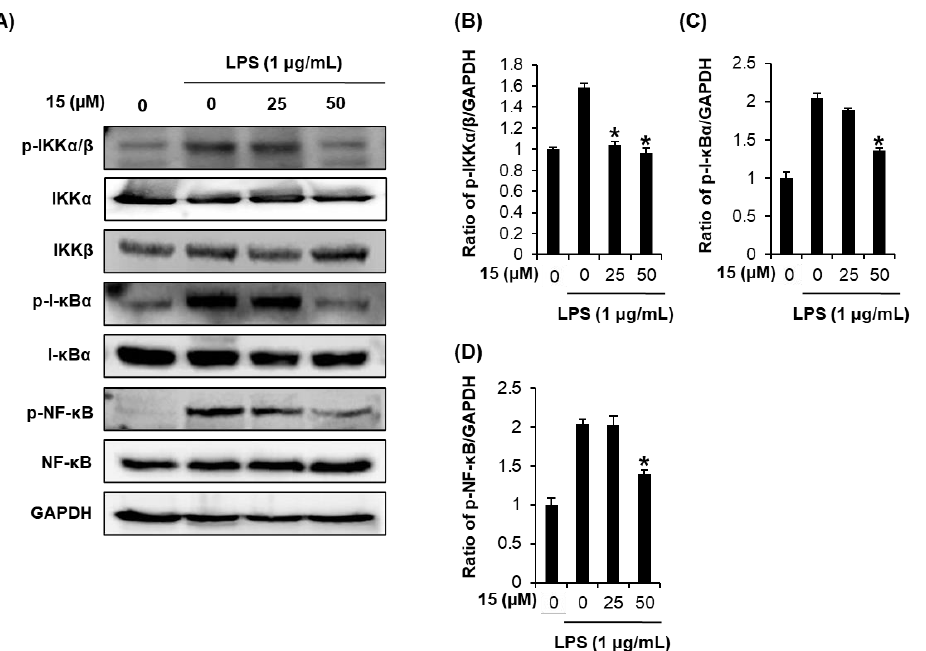
Figure 4. Effects of benzyl salicylate ( 15 ) on the expression of IκB kinase alpha and beta (IKKα/β), inhibitor of kappa B alpha (I-κBα), and nuclear factor kappa B (NF-κB) in RAW 264.7 mouse macrophages treated with lipopolysaccharide (LPS). ( A ) Representative western blots showing protein expressions of IKKα/β, phospho-IKKα/β (p-IKKα/β), I-κBα, phospho-IKKα/β (p-I-κBα), NF-κB, and glyceraldehyde-3-phosphate dehydrogenase (GAPDH). ( B – D ) Quantitative bar chart for each protein’s expression level (mean ± SD, * p < 0.05 compared to group treated with 1 μg/mL LPS alone).